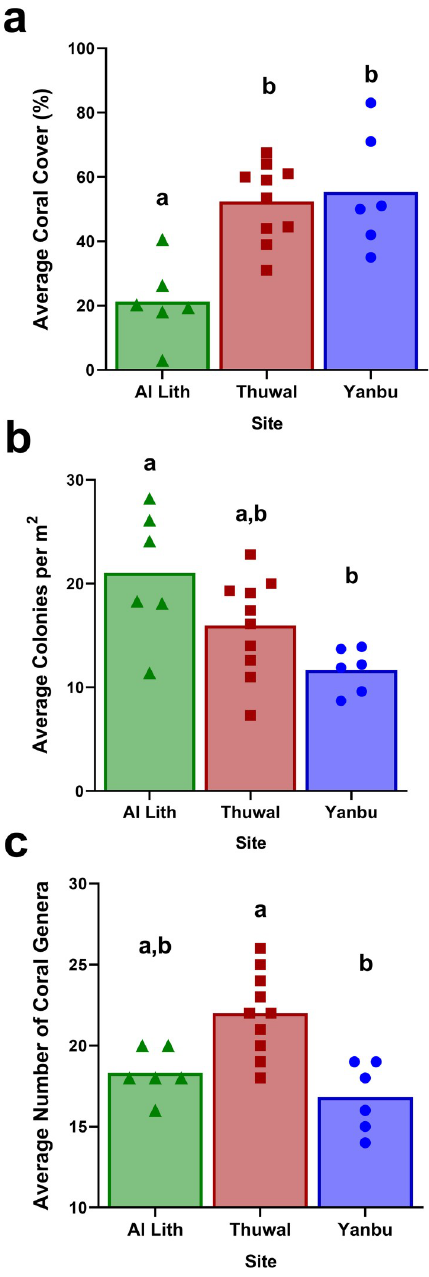
Fig 2. Regional differences in coral cover (a), colony densities (b) and coral genus richness (c). Letters above bars indicate results of Dunn’s multiple group comparison tests. Symbols overlaying the bar graphs indicate the data points for all sites in each region. Six sites each were surveyed in Al Lith (triangles) and Yanbu (circles) and ten sites in Thuwal